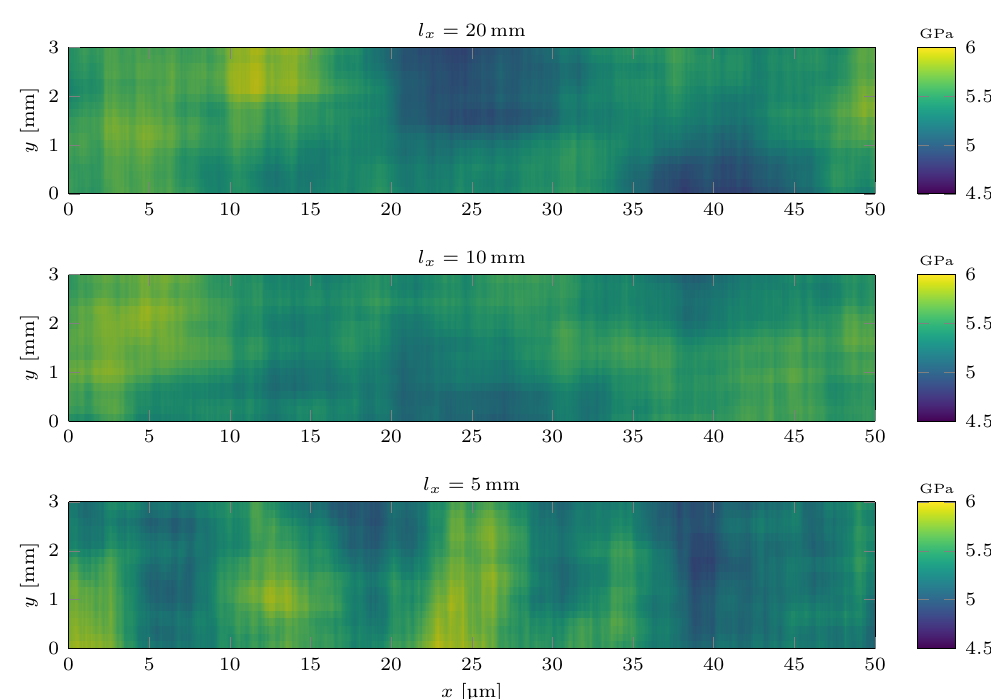
Figure 10. Discretizations of cross-correlated homogeneous second-order Gaussian random fields to represent the spatially distributed material parameter Λ for different values of l x